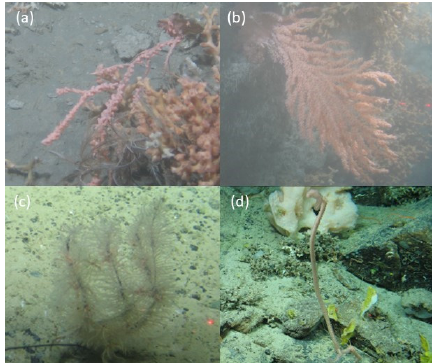
Figure 5. In situ photographs taken by ROV Holland I representing the gross morphology of ( a ) Haplotype 35 Primnoa sp. (M31), ( b ) Haplotype 36 Primnoa sp. (M31), ( c ) Haplotype 37 Thouarella grasshoffi (M35), and ( d ) Haplotype 38 Calyptrophora clinata (M36). Diversity 2022 , 14 , x FOR PEER REVIEW